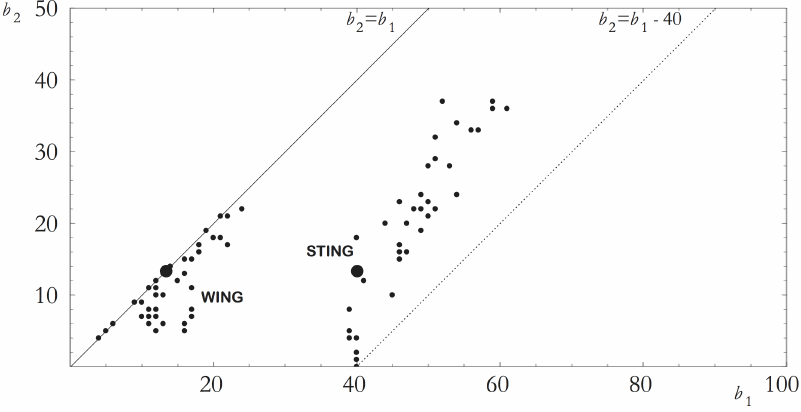
Figure 1. The contract set (source: